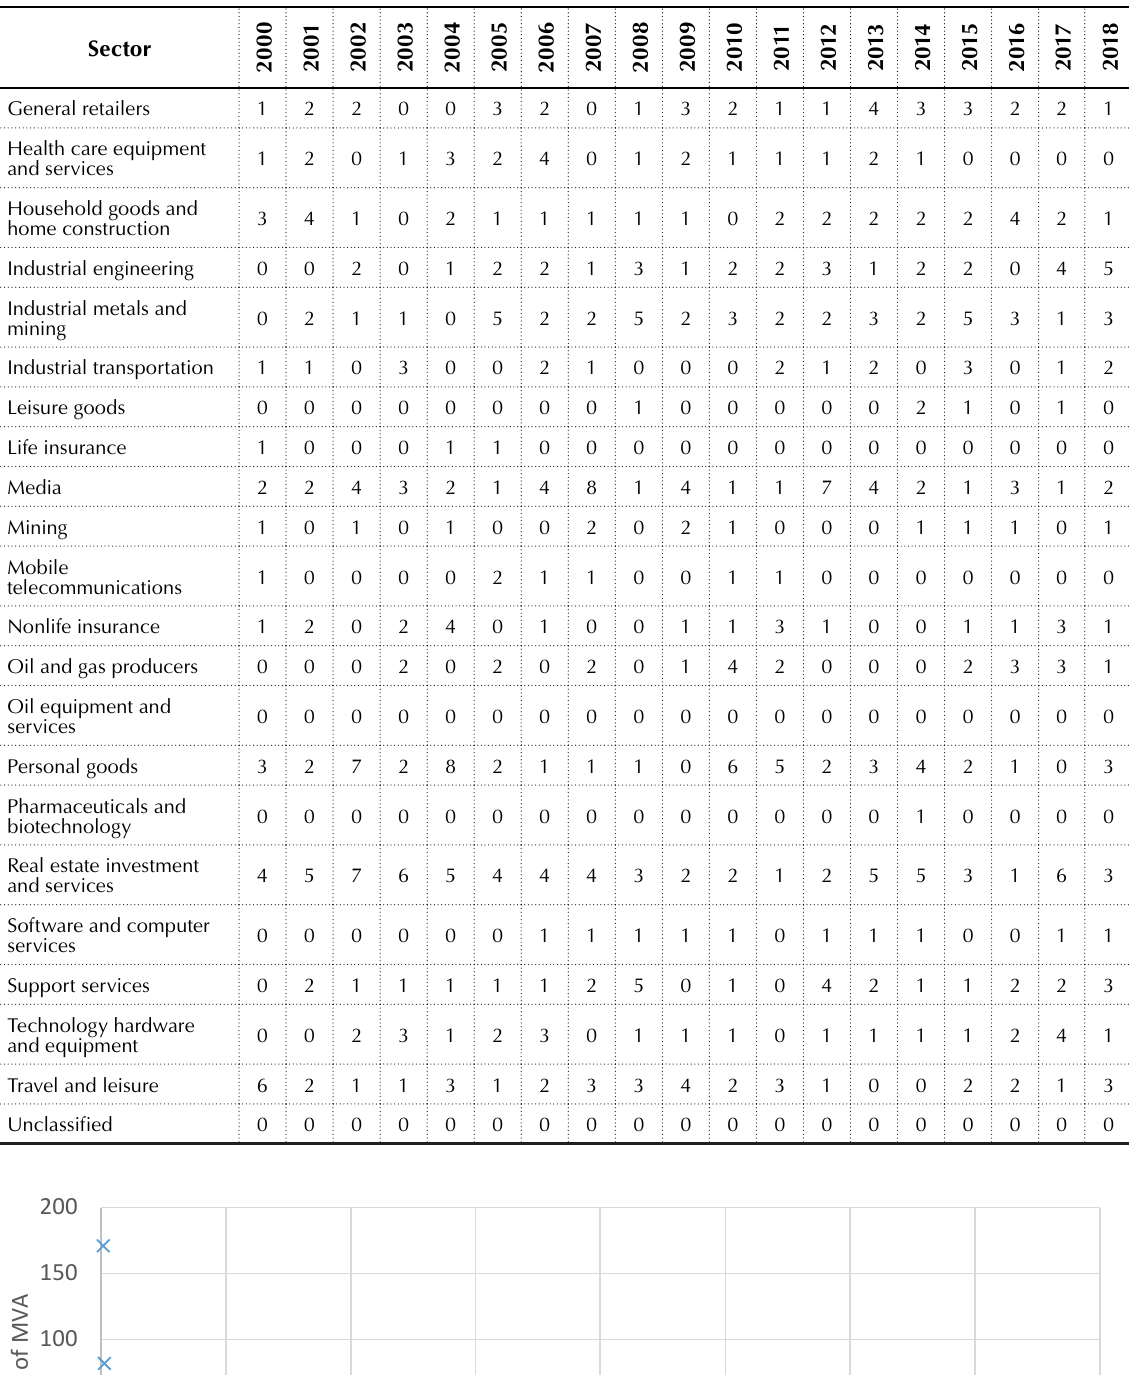
Table 5 (cont.). The industrial sector of top 50 MVA’s change stocks during